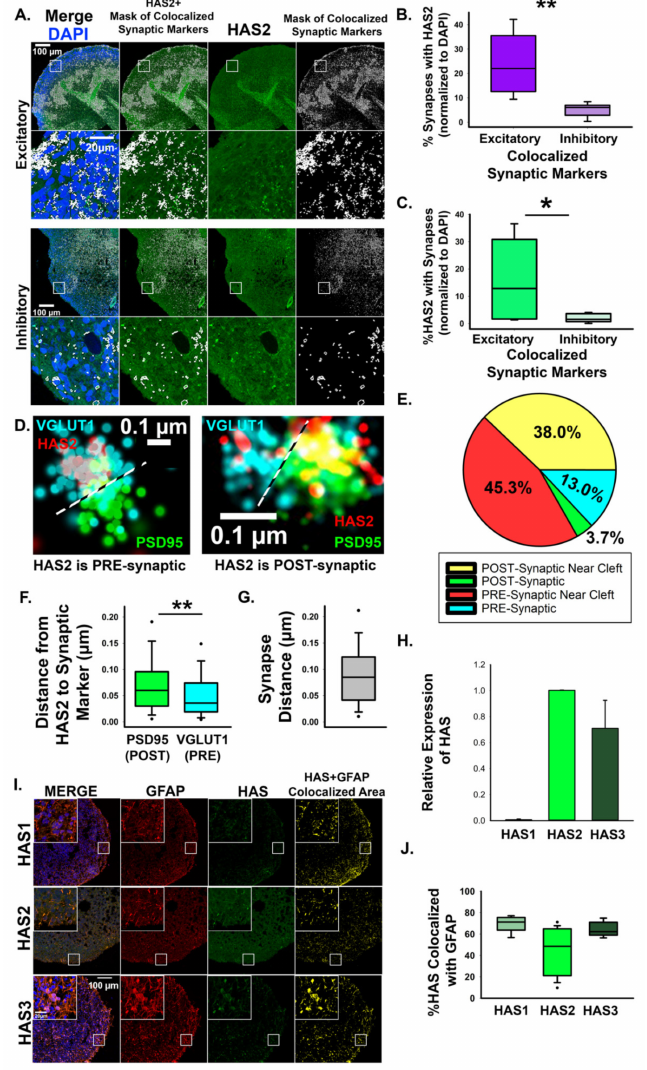
Figure 2. Hyaluronan synthase, HAS2, localizes to excitatory synapses. ( A ) Representative confocal images of HAS2 together with colocalized excitatory synapse markers, VGLUT1 and PSD-95, and colocalized inhibitory synapse markers, VGAT and gephyrin. Panels show DAPI (blue), HAS2 (green) and a mask of colocalized synaptic markers (white). Co-localization analysis between HAS2 and the area defined by the colocalized synapse mask reveals that HA is preferentially enriched at excitatory synapses. ( B , C ) Quantification of HAS2 synaptic localization shown in A. n = 9 total spheroids derived from 3 separately grown spheroid sets for each set of synaptic markers. * p = 0.027 ** p < 0.001. ( D ) dSTORM imaging reveals that HAS2 localizes to pre- and post-synaptic compartments of excitatory synapses. The pre-synaptic marker VGLUT1 is shown in blue, HAS2 is shown in red, and post-synaptic PSD95 is shown in green. ( E ) Pie chart showing preferred synaptic localization of HAS2. Within 100 nm of the synaptic cleft is distinguished as ‘near cleft’. ( F ) Quantification of the average distance between HAS2 and synaptic markers. n = 168 synapses from 9 total spheroids derived from 3 separately grown spheroid sets, ** p < 0.001. ( G ) Quantification of the average distance from pre- (VGLUT1) to post-synaptic (PSD95) markers demonstrates that HAS2 is closer to the cleft at the pre-synaptic VGLUT1-postive compartments. ( H ) qRT-PCR relative mRNA expression of HAS1 and HAS3 as compared to HAS2. ( I ) Representative images of cortical spheroids stained for HAS isoforms (green), GFAP (red), and DAPI. Far right panel (yellow) is the area of colocalization between HAS and GFAP. Scale bar 100 µ m, inset: 20 µ m. ( J ) Quantification of HAS and GFAP